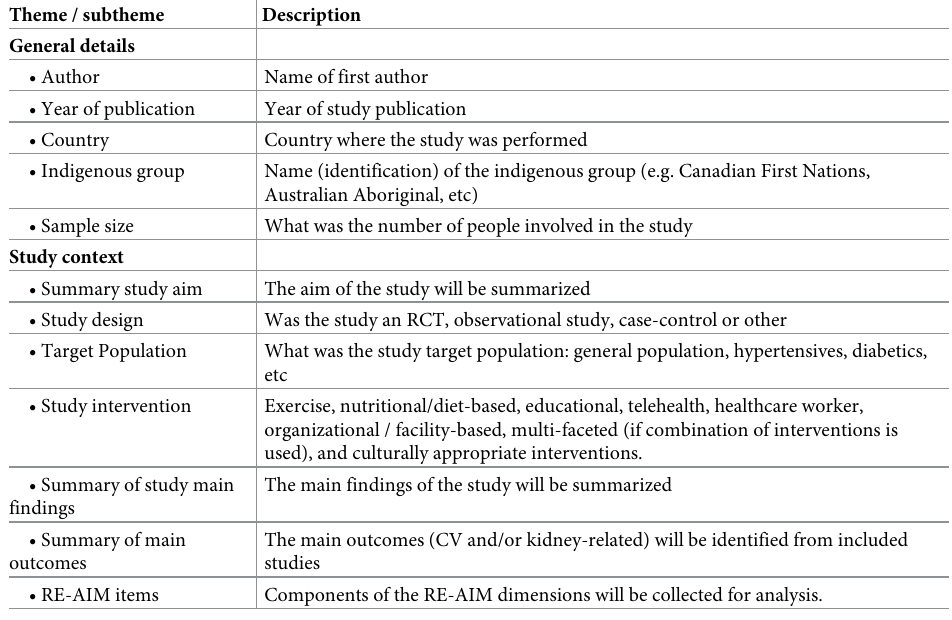
Table 2. Data extraction and charting for empirical literature